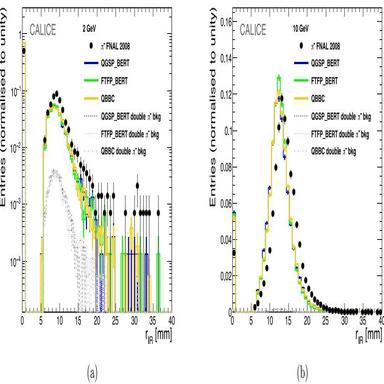
The IR distribution for energies of 2 GeV (a) and 10 GeV (b) of the beam energy. Other details follow those of.